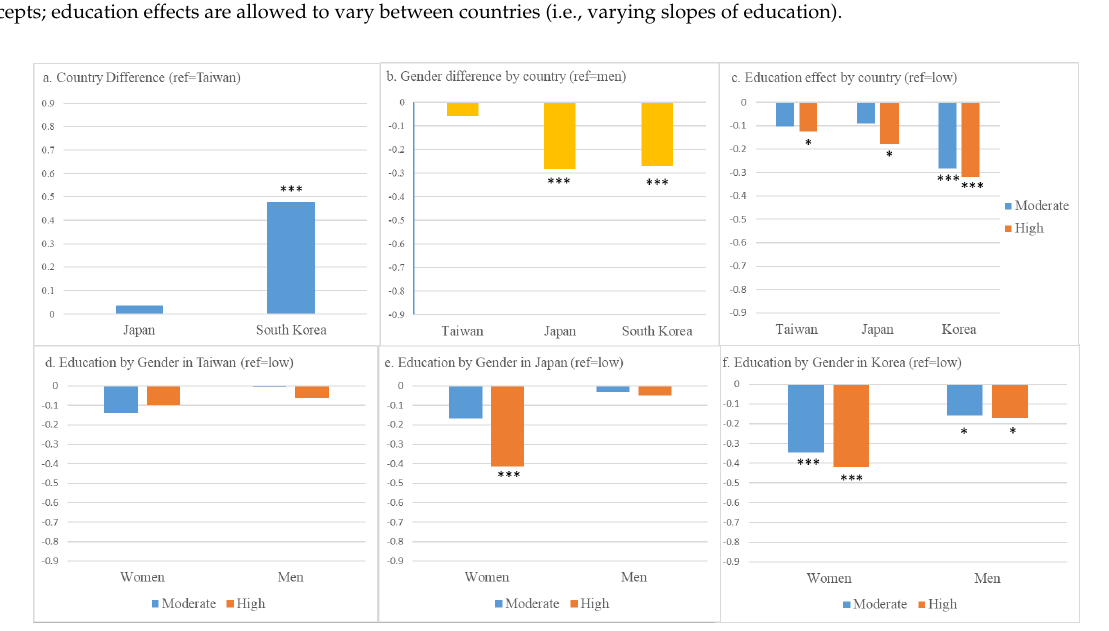
Figure 2. Gender and education effects on attitudes toward women business leadership in three Asian countries, the WVS. Note: * p < 0.05; ** p < 0.01; *** p < 0.001. Figure presents average marginal effects of each factor based on logistic regression models. Positive estimates indicate a higher likelihood of supporting traditional attitudes that favor men over women in business leadership. ( a ) shows the main effect of country; ( b ) shows the main effect of gender in each country; ( c ) shows